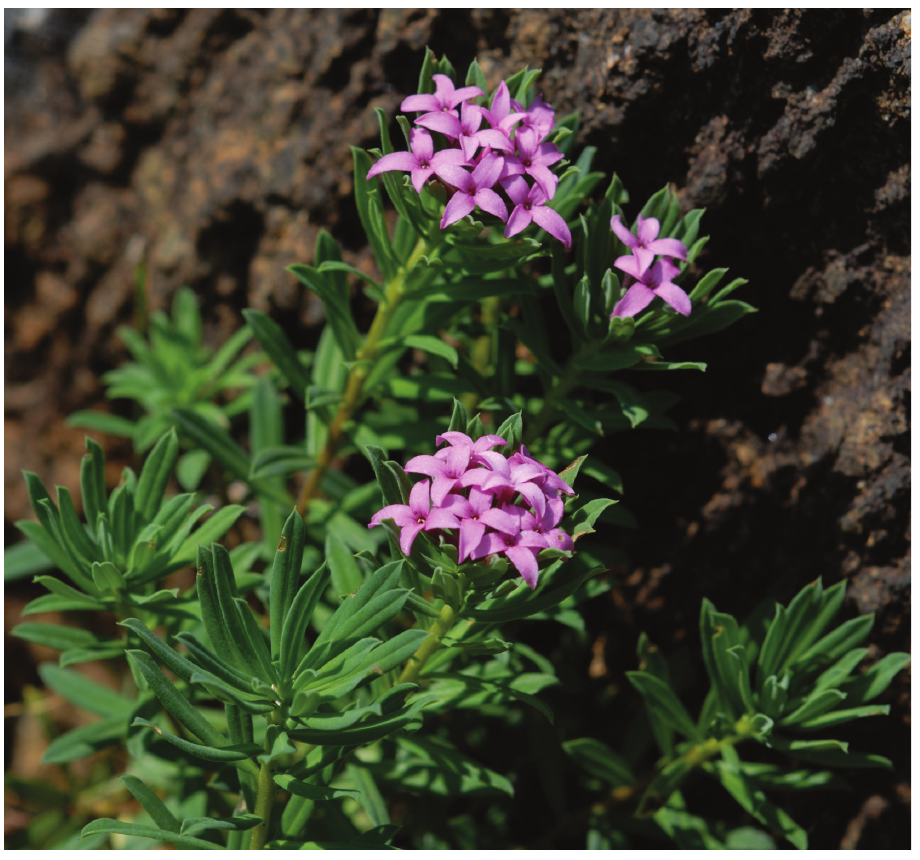
Figure 5. Daphne cneorum in Piedmont (Italy). Picture by Alberto Selvaggi. areas (Euro+Med 2006). In Italy, D. cneorum has been reported for Piemonte, Lom- bardia, Trentino-Alto Adige, Veneto, Friuli Venezia Giulia, Liguria, Emilia-Romagna, and Toscana (Fig. 6; Bartolucci et al.